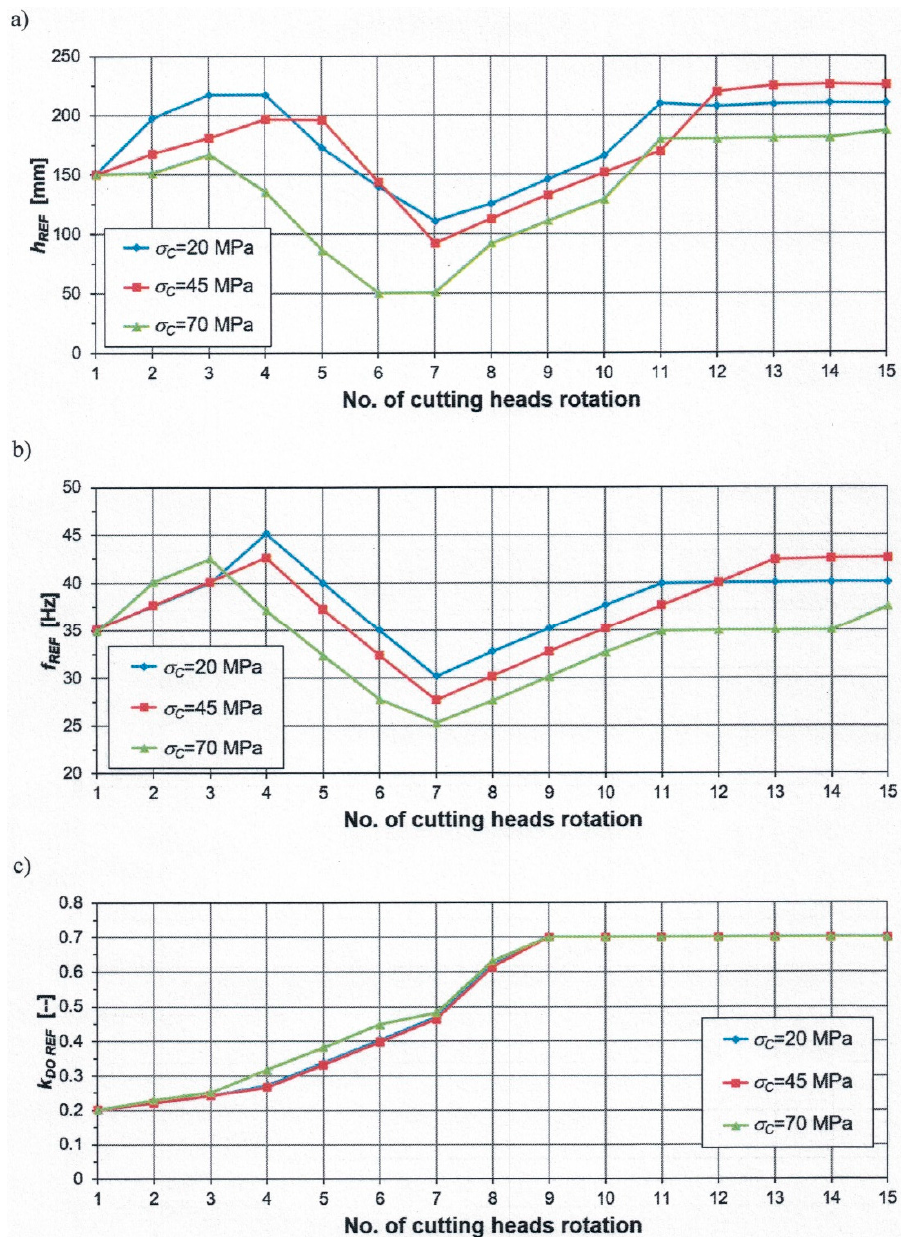
Figure 3. Setpoint values worked out by the setting system: ( a ) cut height ( h REF ), ( b ) supply voltage frequency ( f REF ), and ( c ) opening coefficient of the electrohydraulic valve ( k DO REF ) in subsequent rotations of the cutting heads when making lower cuts in automatic mode in rocks with different uniaxial compressive strengths.